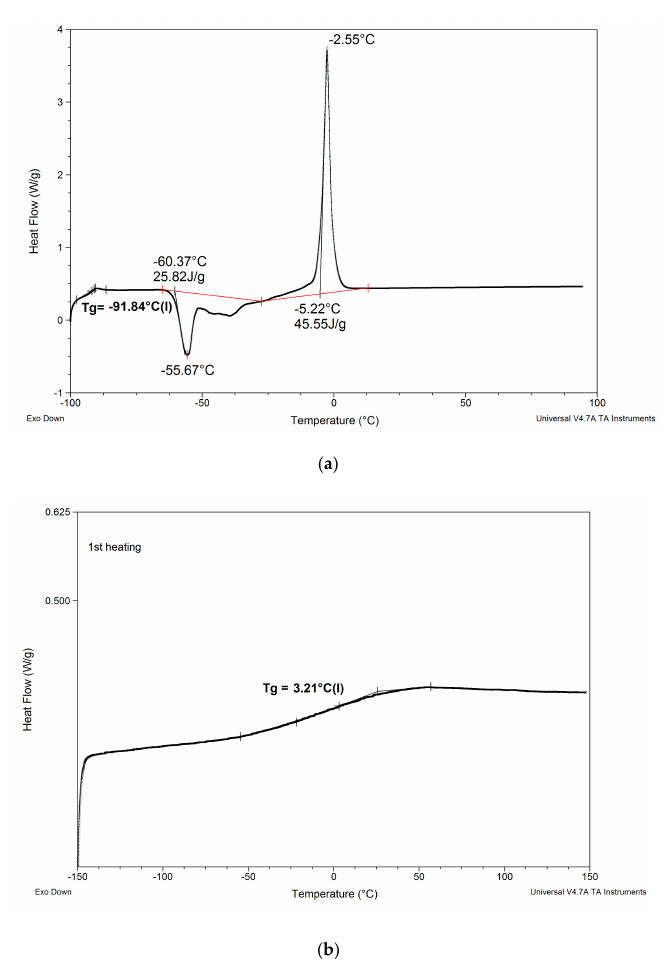
Figure 9. Comparison of DSC patterns of reactive IL 3 ( a ) and UV-cured reactive IL 3 ( b